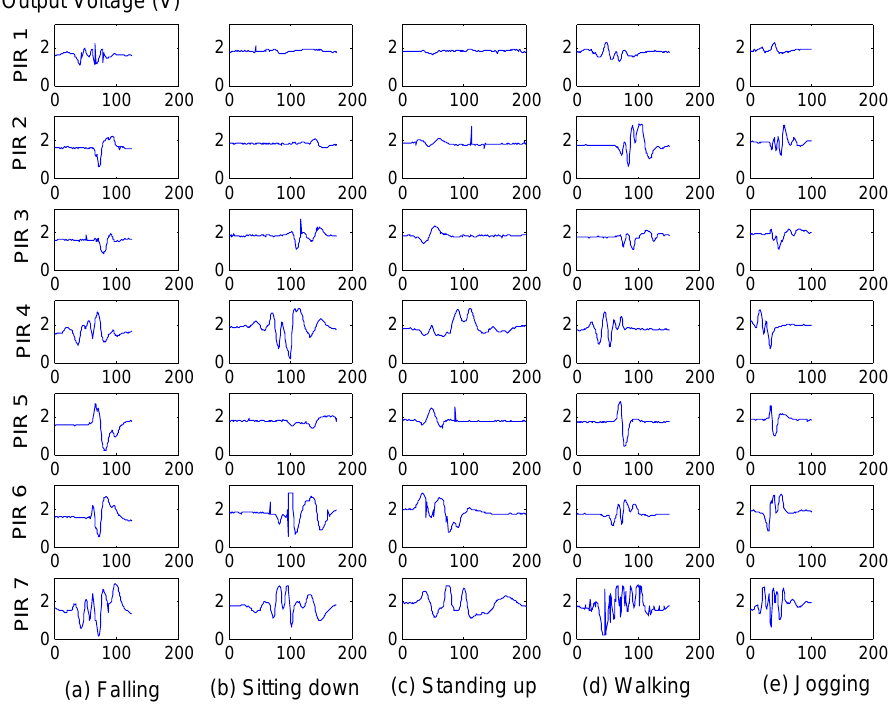
Figure 6. The original output of the sensor node with seven PIR sensors for different activities: ( a ) Falling; ( b ) Sitting down; ( c ) Standing up; ( d ) Walking; ( e ) Jogging. The horizontal axis represents the sampling points (25 Hz) of the activity.